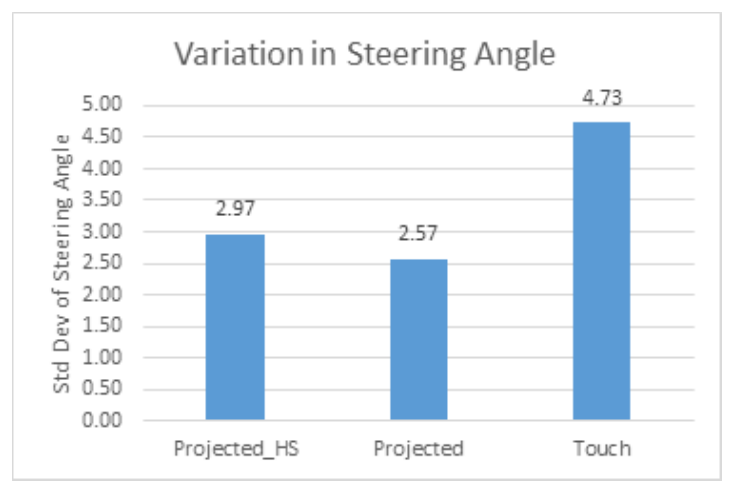
Figure 28. Comparing Driving Performance in terms of standard deviation of steering angle.